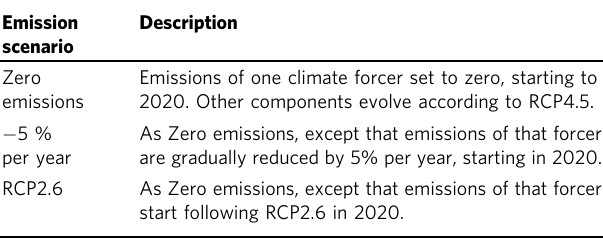
Table 1 Idealized emission scenarios.